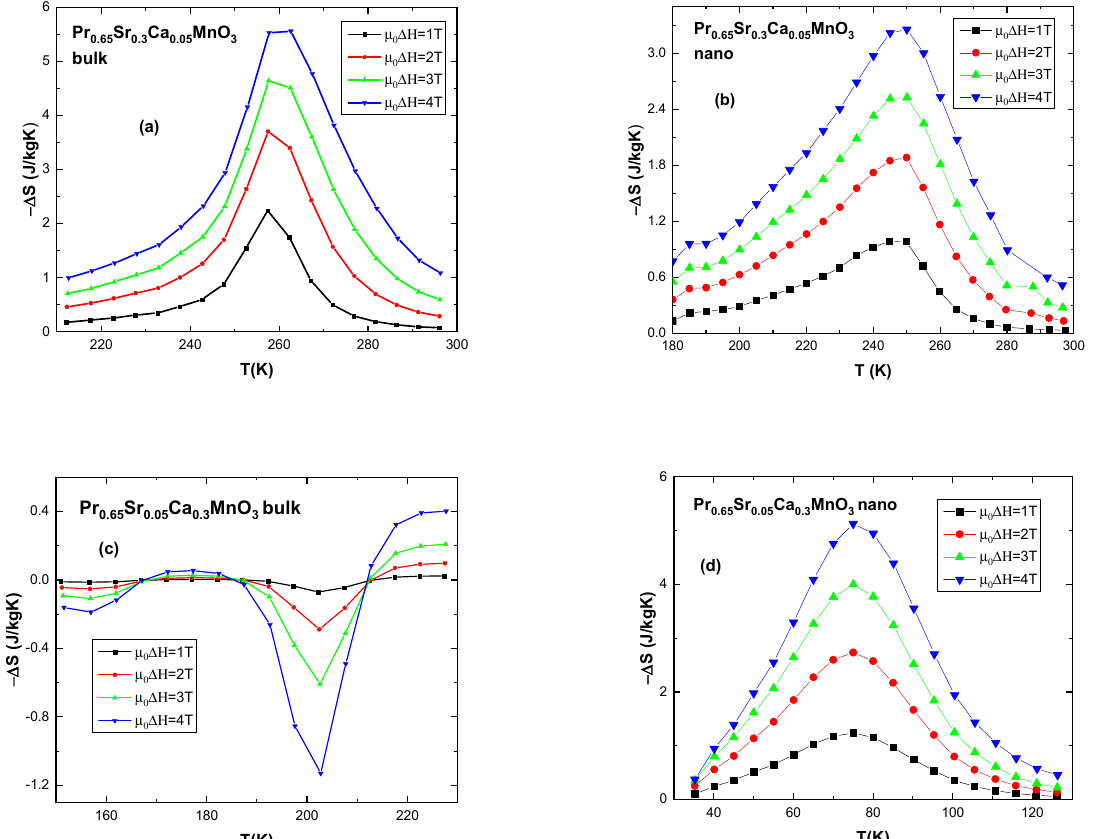
Figure 10. Magnetic entropy change vs. temperature for selected samples: ( a ) x = 0.05 bulk; ( b ) x = 0.05 nanocrystalline sample; ( c ) x = 0.3 bulk at AFM-FM; ( d ) x = 0.3 nanocrystalline at low tempera- ture.